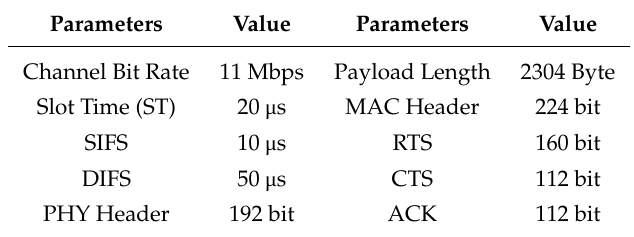
Table 1. PHY layer and MAC layer parameters used in